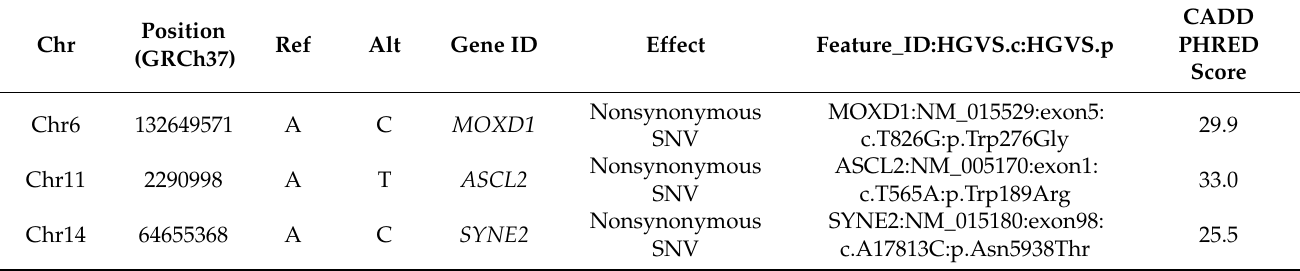
Table 1. Rare variants identified by exome sequencing and variant